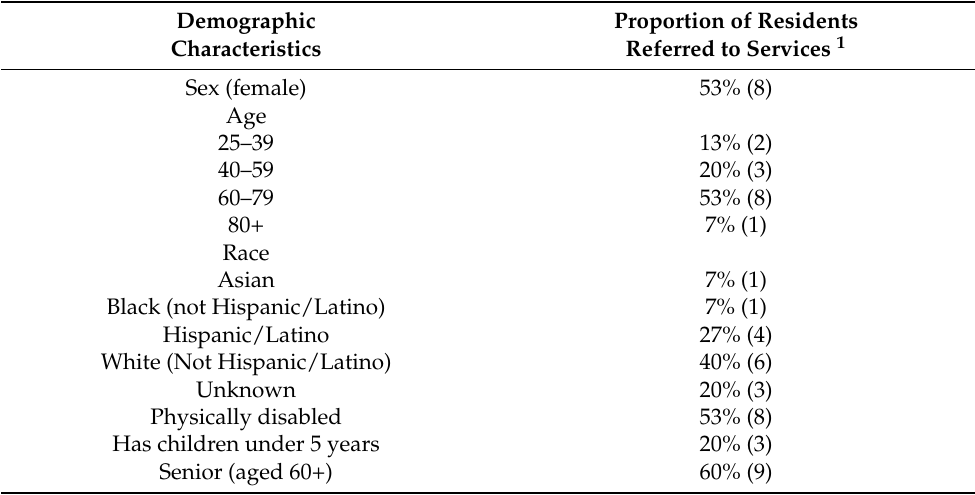
Table 1. Demographics of Residents Referred by Inspectors to Social Services.